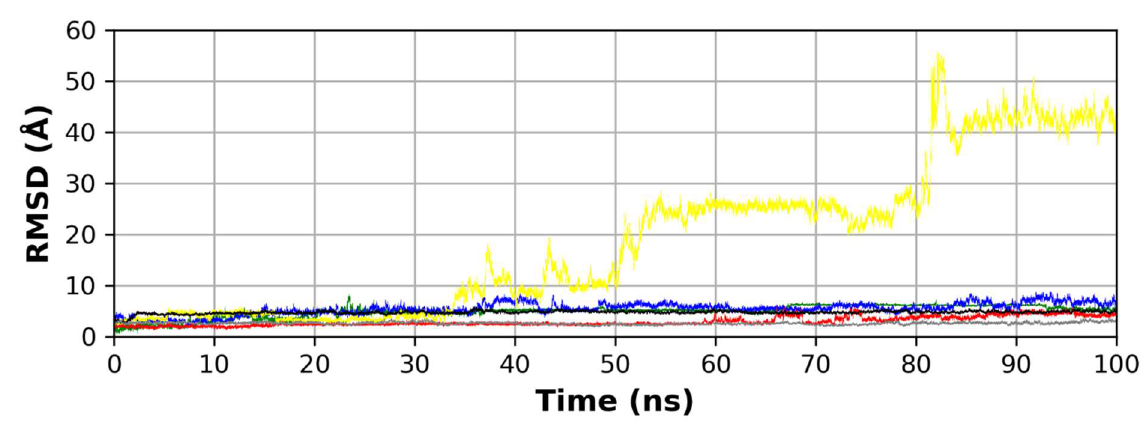
Figure 4. RMSD of each compound in the six MD runs. (Green: complex 1 (ferulic acid), blue: complex 2 (rutin), yellow: complex 3 (gallic acid), red: complex 4 (chlorogenic acid), black: complex 5 (co-crystallized N3), gray: complex 6 (docked N3)).